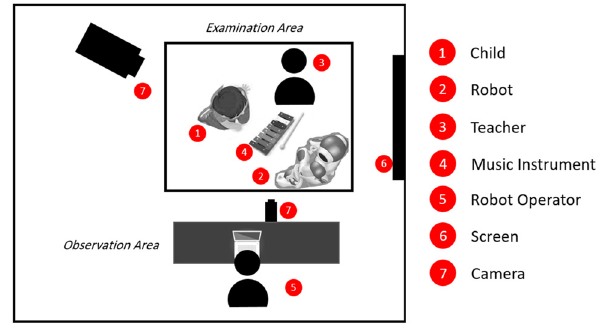
Figure 1: The schematic of the intervention room and its main